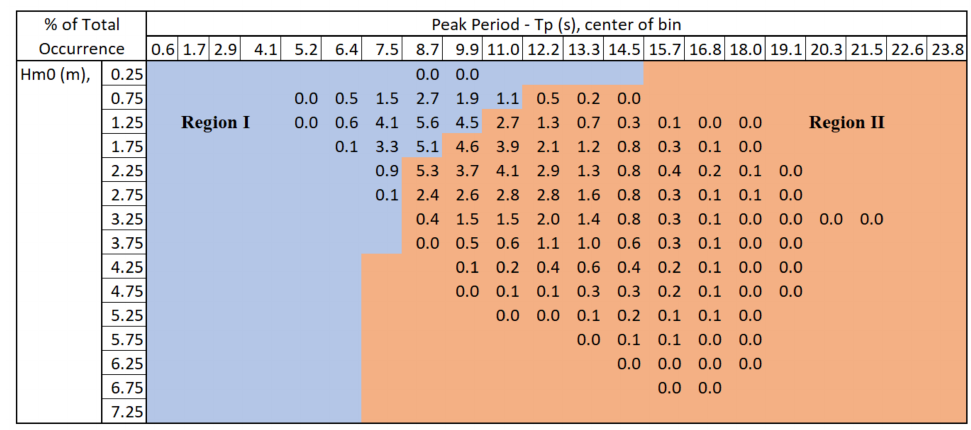
Figure 7. % of Total Occurrences at DOE reference site overlaid on Operating Region for the Heaving Buoy.